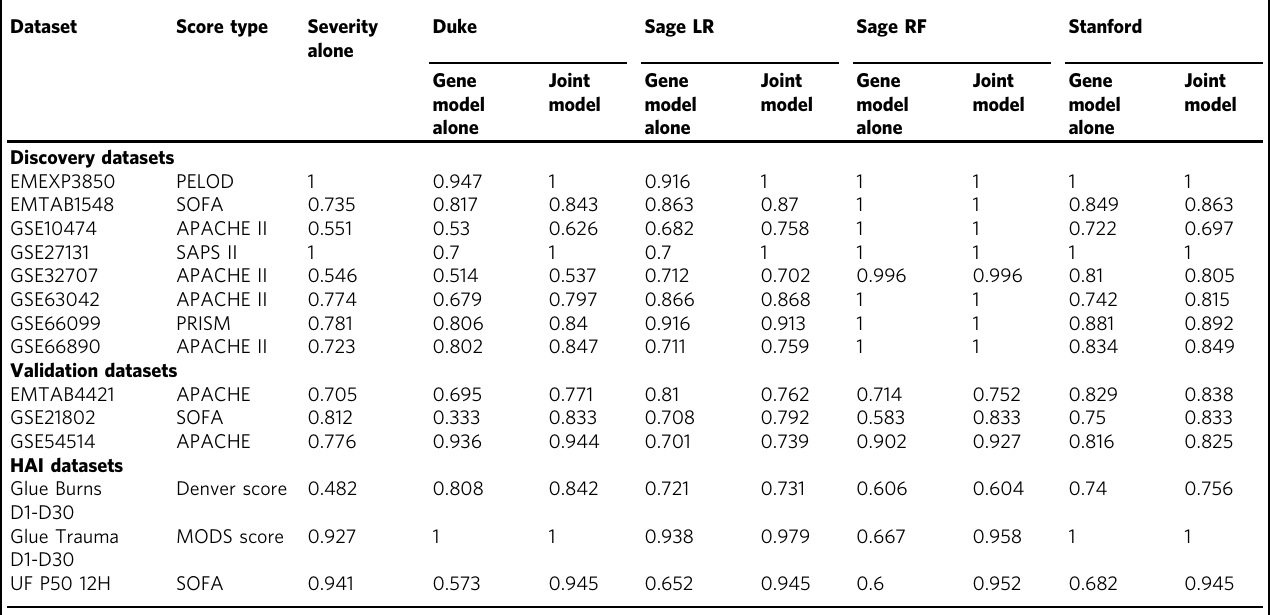
Table 2 AUROC with genomic features and clinical severity